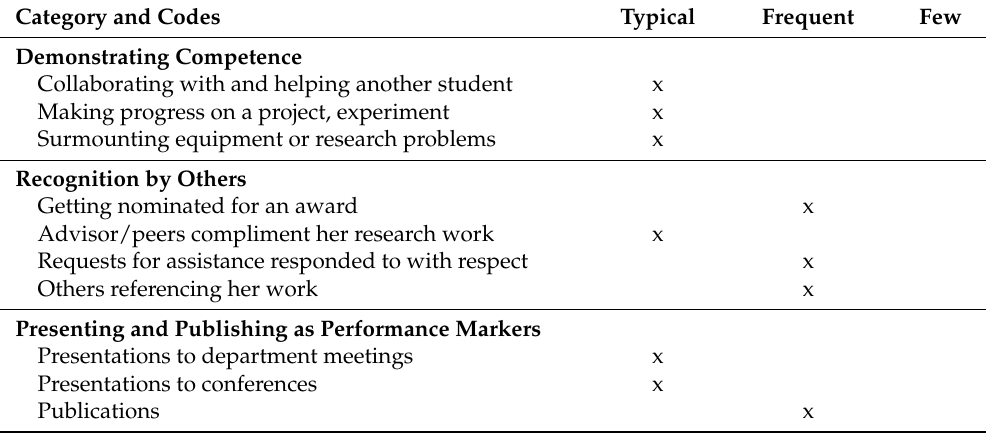
Table 2. Incidents that Increased Recognition of Self as a Scientist.